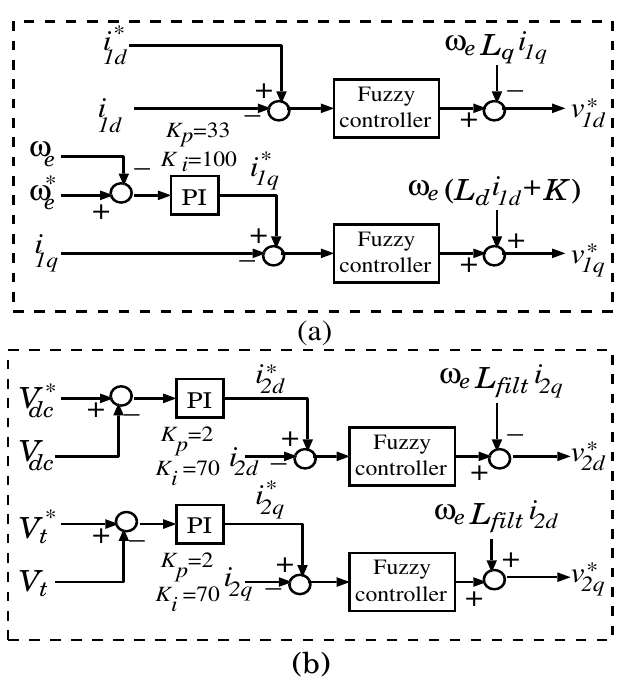
Figure 7. ( a ) Generator-side converter control system; ( b ) Grid-side inverter control system.